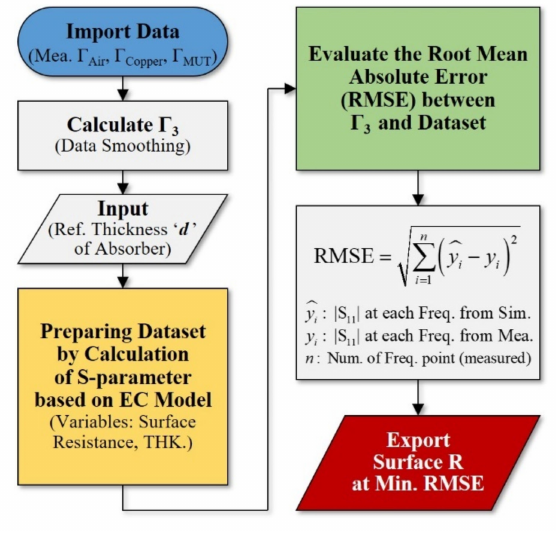
Figure 8. Procedure for surface resistance prediction of an optical transparent absorber based on the near-field antenna measurement method.